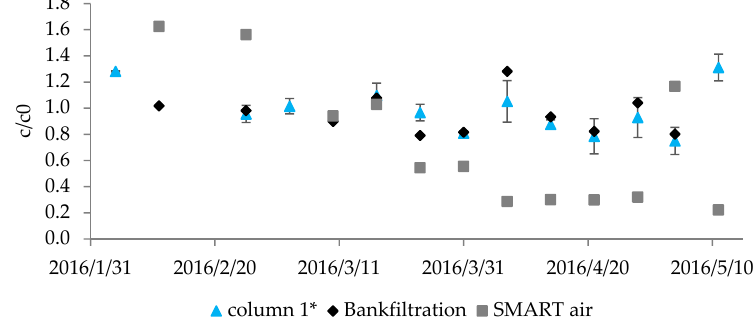
Figure 5. Improved removal efficiency of sulfamethoxazole in the SMART air system; * mean value of first column effluents, n = 2.